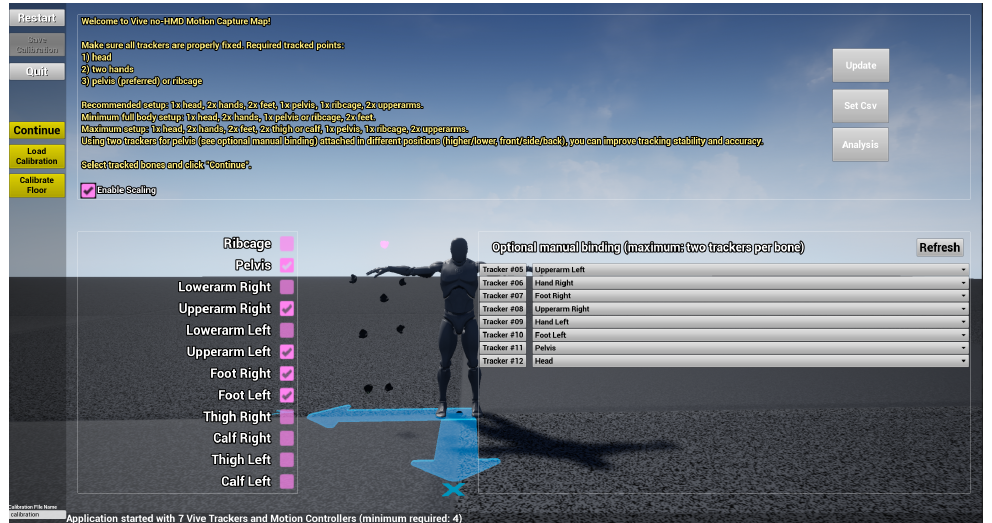
Figure 7. Assignment of sensors to body parts during calibration of the BiomacVR system. An assistant person is not visible in the system and has no effect on the representation of a